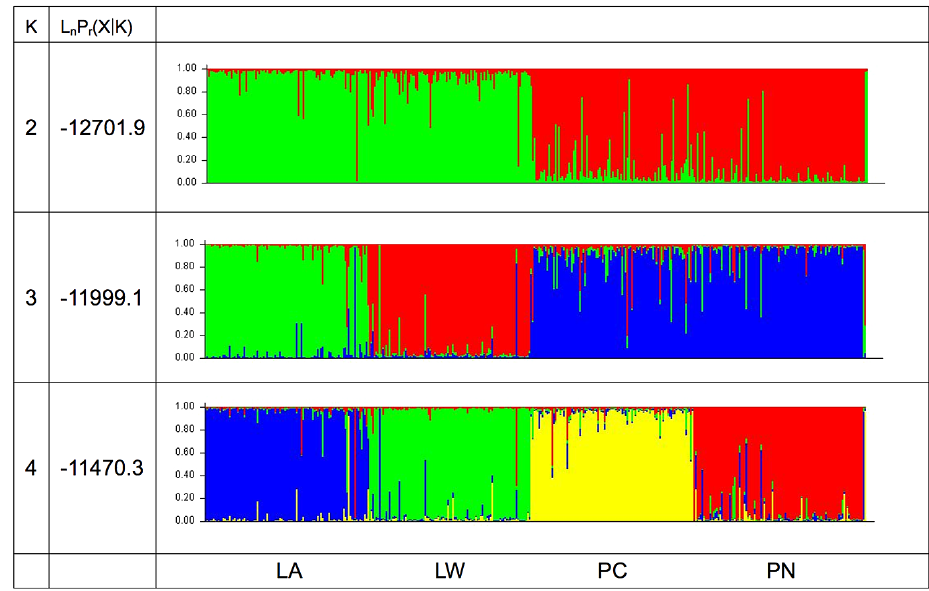
Figure 3. Graphical representation of the estimated membership fractions of individuals of the breed analysed in each of the K inferred clusters, for K = 2 to K = 4.